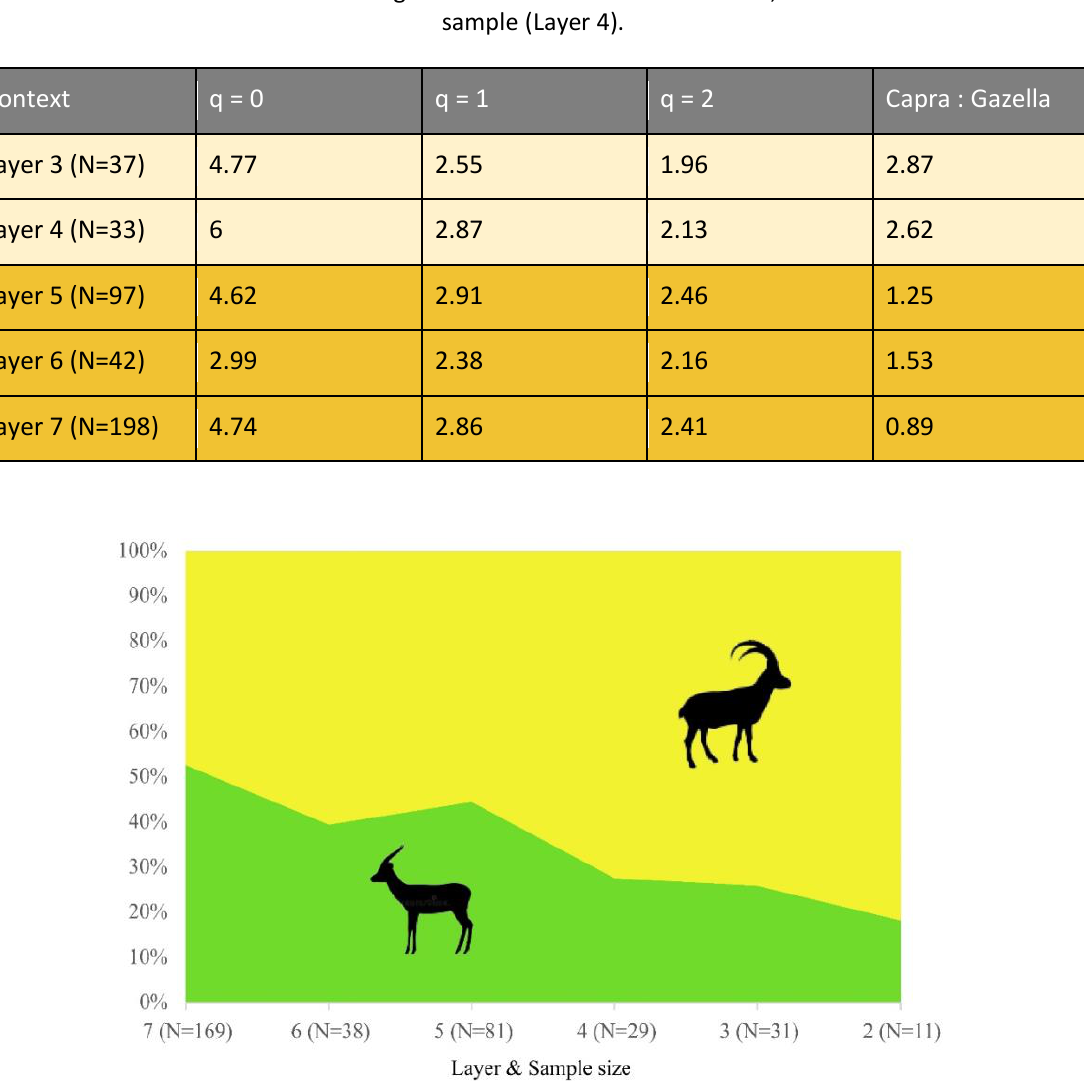
Figure 5: The changing ratio of caprine to gazelle bones throughout the sequence in NR2 constitutes a statistically-significant trend (Cochran-Armitage Test Z = -2.61, p-value = 0.009). Age at death and sex